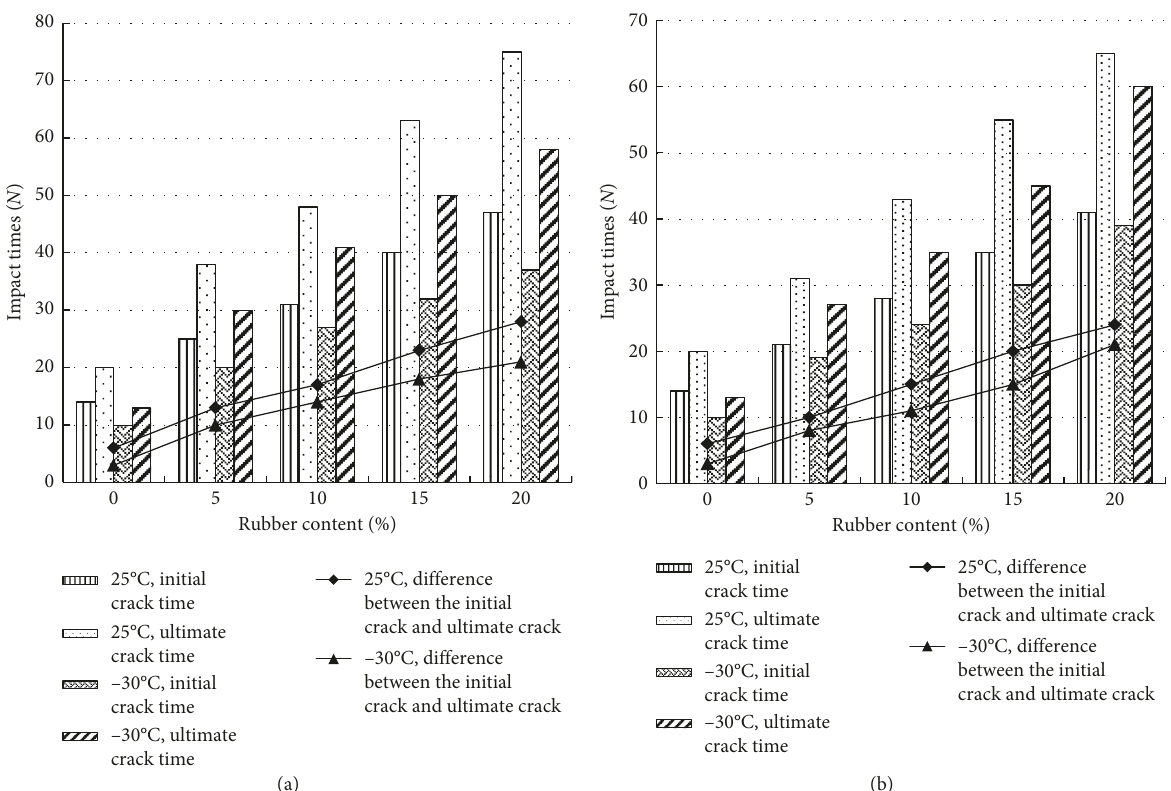
Figure 3: Relationship between the rubber content and impact times of the rubber concrete specimens. Rubber powder: (a) 20mesh and (b) 50